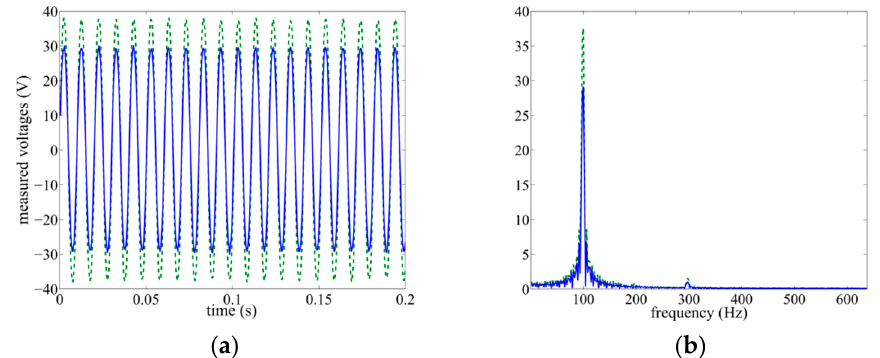
Figure 9. (a) Measured voltages and ( b ) Fourier analysis of measured voltages on phase 1 for a spin speed of 6000 rpm and a rotor center shift of 1 mm (along the y-axis).